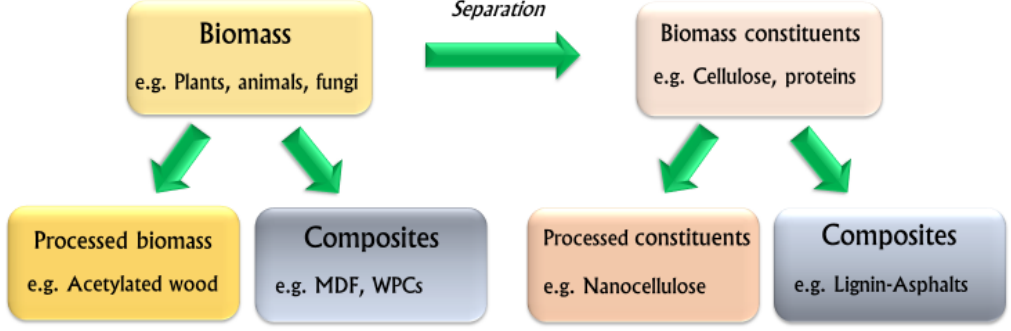
Figure 1. Diagram showing research topics in the field of bio-based polymers.